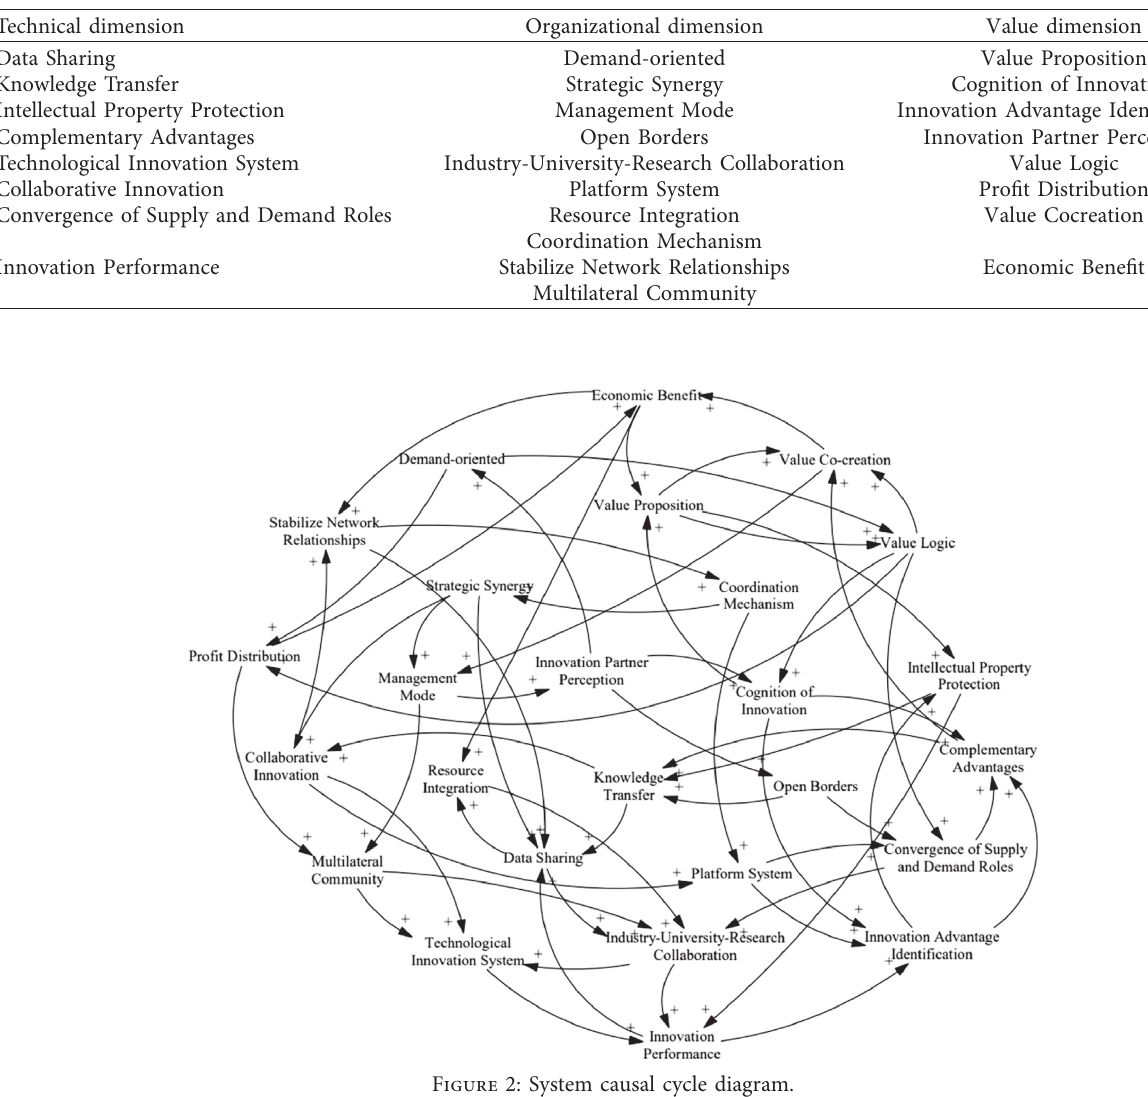
Table 2: Main system variables.